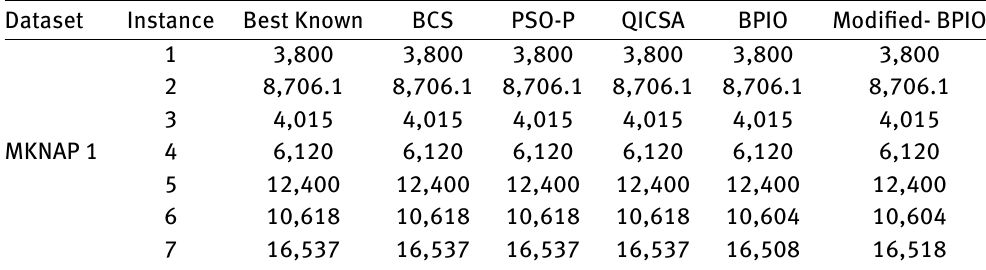
Table 8: The best results achieved by the Modified-BPIO and other comparative methods Dataset Instance Best